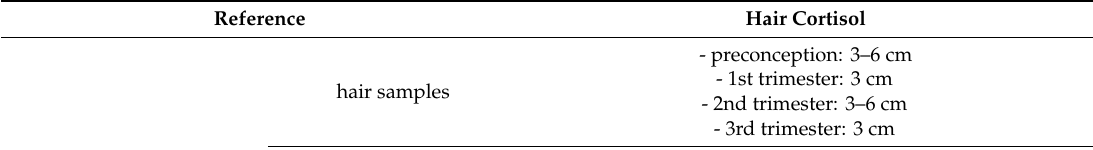
Table 3. Laboratory analysis of hair samples.